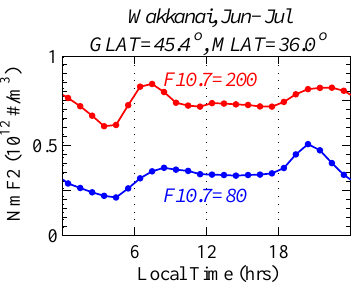
Figure 2. Local time variations of Wakkanai summer Nm F2 de- rived from the Nm F2– F 10 . 7 quadratic fitting, red for F 10 . 7 = 200 and blue for F 10 . 7 =